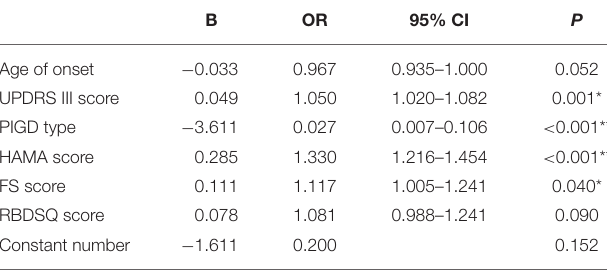
TABLE 3 | Logistic regression analysis of factors associated with PD-D. B OR